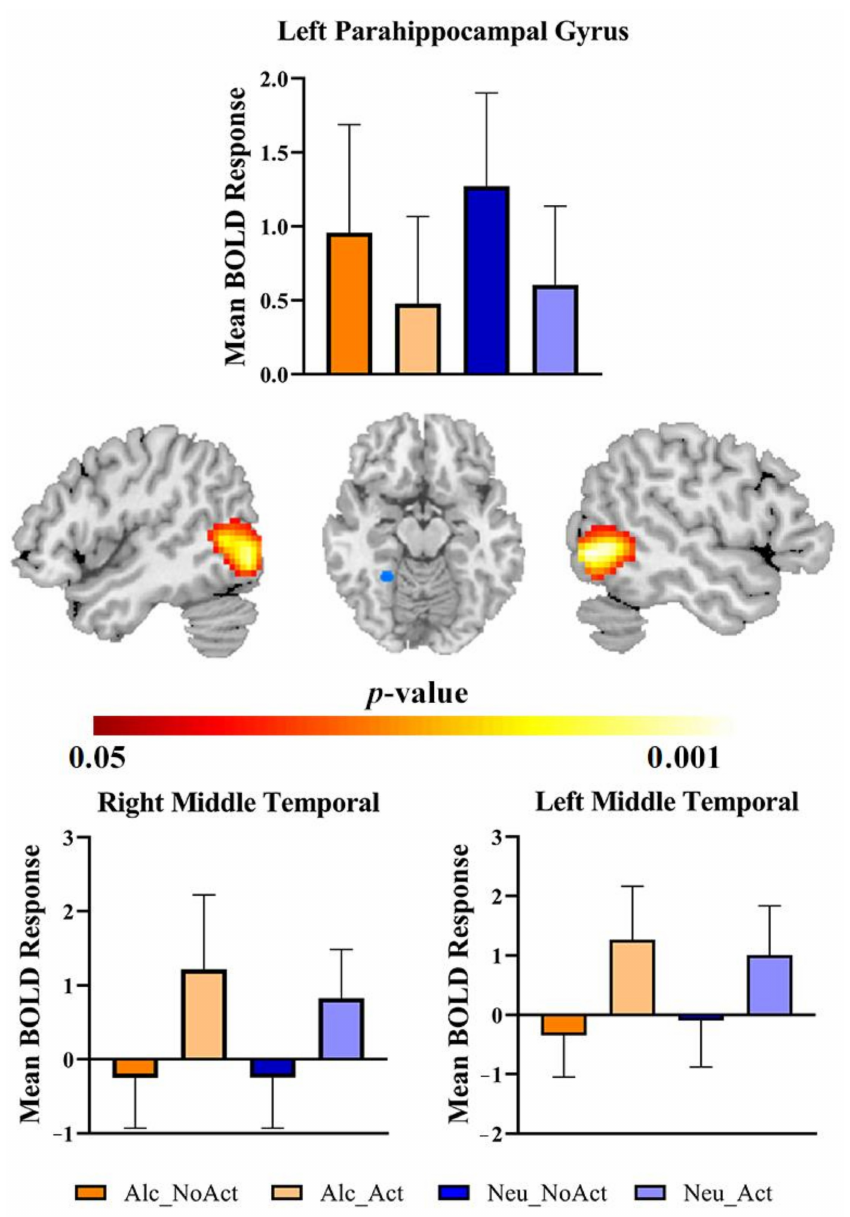
Figure 2. Brain activations of cue type main effect (i.e., action versus no-action). Alc_NoAct = alcohol cues without drinking actions, Alc_Act = alcohol cues with drinking actions; Neu_NoAct = non- alcohol cues without drinking actions, Neu_Act = non-alcohol cues with drinking